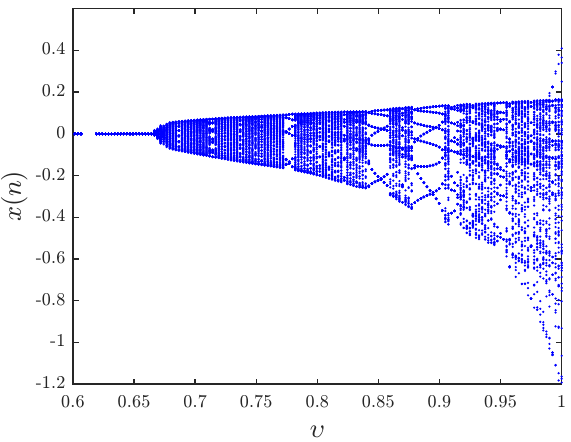
Figure 6. Bifurcation diagram of the fractional Tinkerbell map (7) with υ ∈ [ 0,1 ] , ∆ υ = 0.005, ( α , β , γ , δ ) = ( 0.9, − 0.6013,2,0.5 ) , and ( x ( 0 ) , y ( 0 )) = ( − 0.72, − 0.64 )